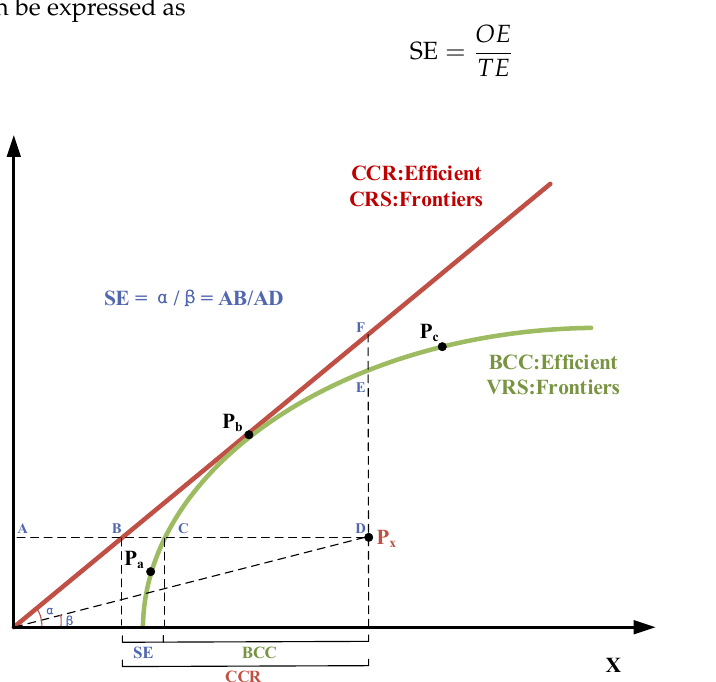
Figure 4. Methods for data envelopment analysis (DEA). The red line represents the CCR model; the green line represents the BCC model.